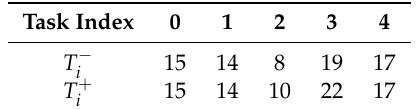
Table 2. The feasible range of each task period after applying static/dynamic